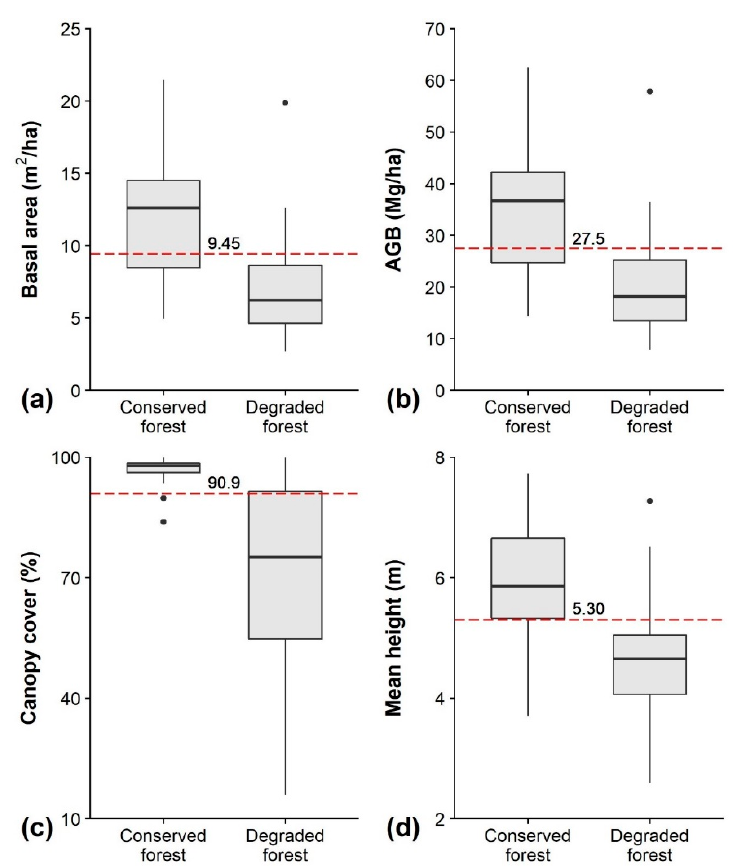
Figure 2. Boxplots of the structural variables that were significantly different between degraded and conserved forest. ( a ) Basal area; ( b ) Biomass; ( c ) Canopy cover; ( d ) Mean height. The threshold value that separates the two status of forests is indicated by red dashed line.